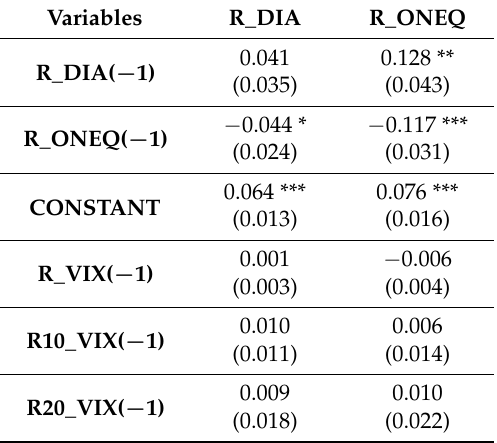
Table 16. Mean Equation for US Market ETF and VIX (whole period) (3 October 2003 to 30 March 2015). Variables